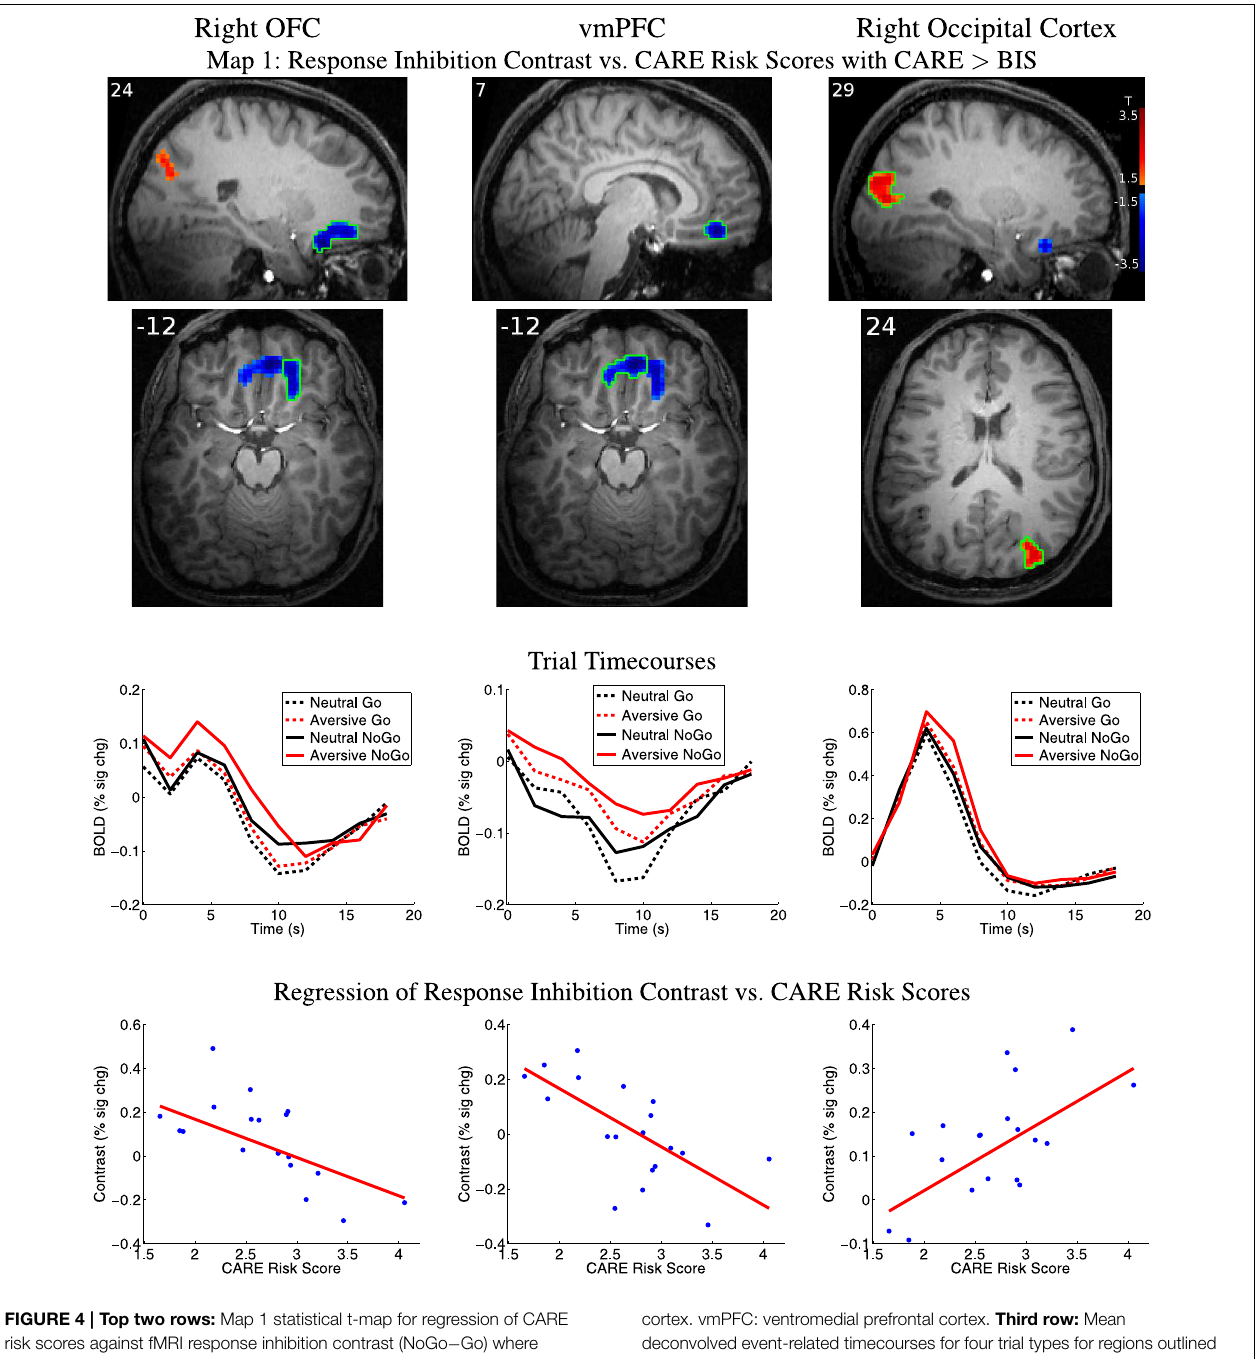
cortex. vmPFC: ventromedial prefrontal cortex. Third row: Mean deconvolved event-related timecourses for four trial types for regions outlined in green in first row. Fourth row: Scatter plots of response inhibition contrast magnitude vs. participants’ CARE risk scores for regions outlined in green in first row. Red line shows linear regression of contrast magnitude against participant risk scores. Maximum values for participants’ statistical influence (Cook’s distance) on linear regression results were: right OFC 0.295, vmPFC 0.760, right occipital 0.247 (see Supplementary Table 1).